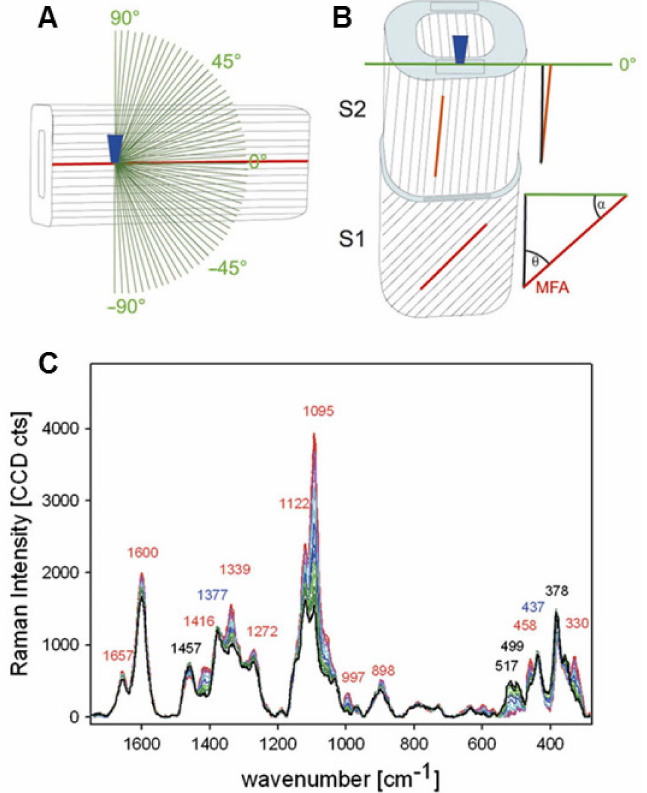
Figure 13. The experimental set-up is depicted schematically in this diagram. ( A ) A microscopic objective (dark blue) focuses the laser beam within the tangential S2 layer of a single latewood fibre, where the cellulose fibril orientation is known to be parallel with respect to the fibre axis. ( B ) A cross-sectional area (light blue) of wood samples is focussed by a laser beam (microscopic objective, dark blue). ( C ) Variations in the fingerprint region of baseline-corrected spectra obtained from one point of the tangential S2 layer of a mechanically isolated single spruce latewood fibre while rotating the incident laser’s polarisation direction in 3 ◦ steps from